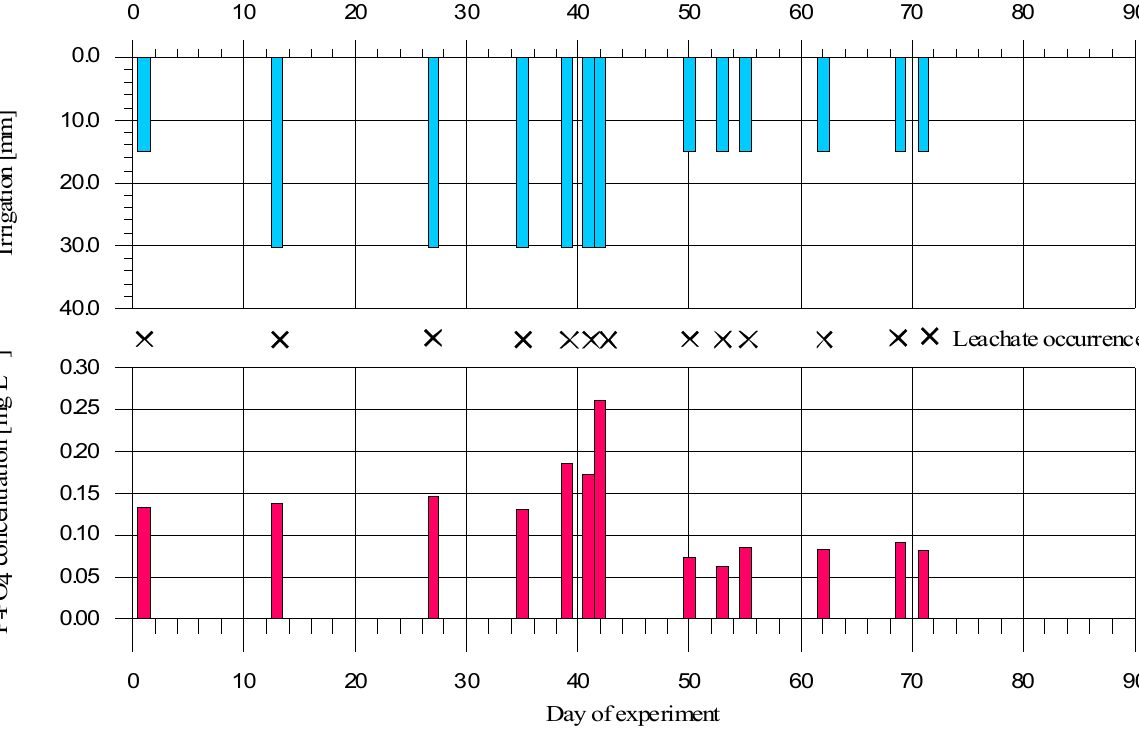
concentration in leachate from 4